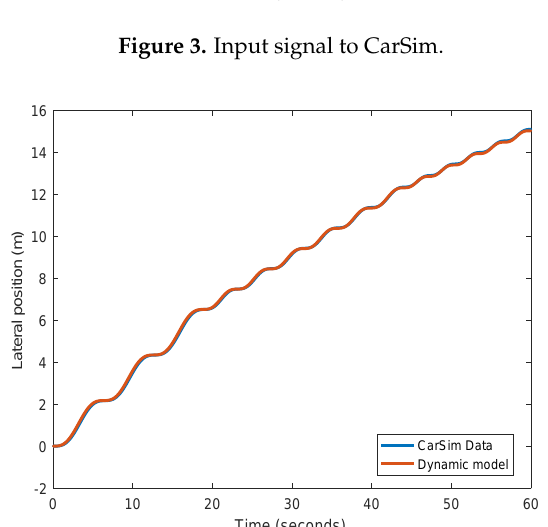
Figure 4. Open-loop responses of the CarSim plant and the identified